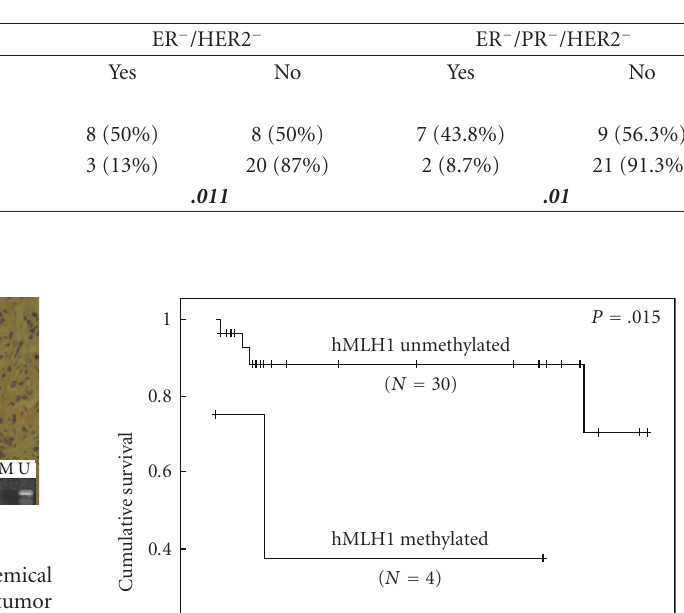
Table 4: Correlation between p53 expression level and double negative (ER − /PR − , ER − /HER2 − ) and triple negative (ER − /PR − /HER2 − ) breast cancer.